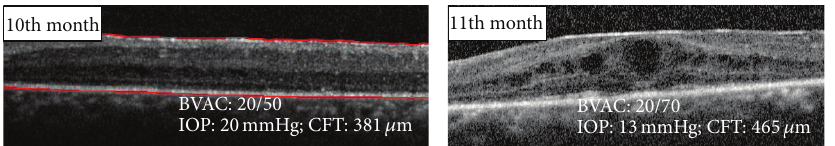
Figure 6: OCT spectral domain OS after 2nd intravitreal injection of